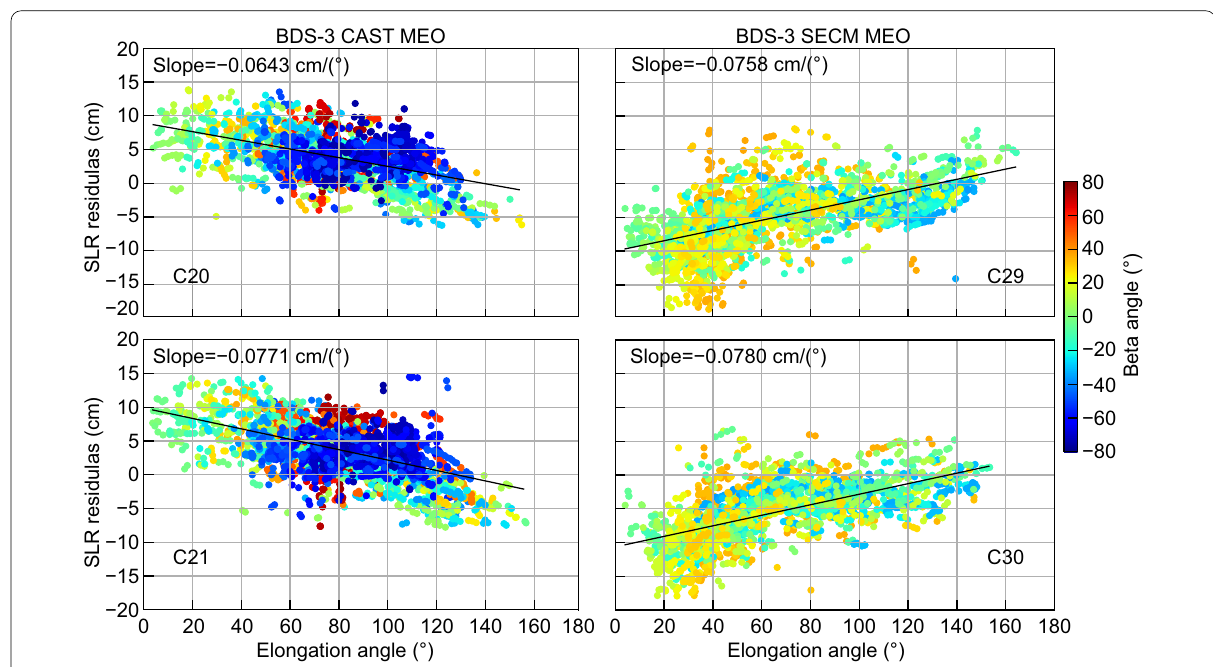
Fig. 9 SLR residuals of BDS-3 MEO satellites tracked with ILRS versus the Sun elongation